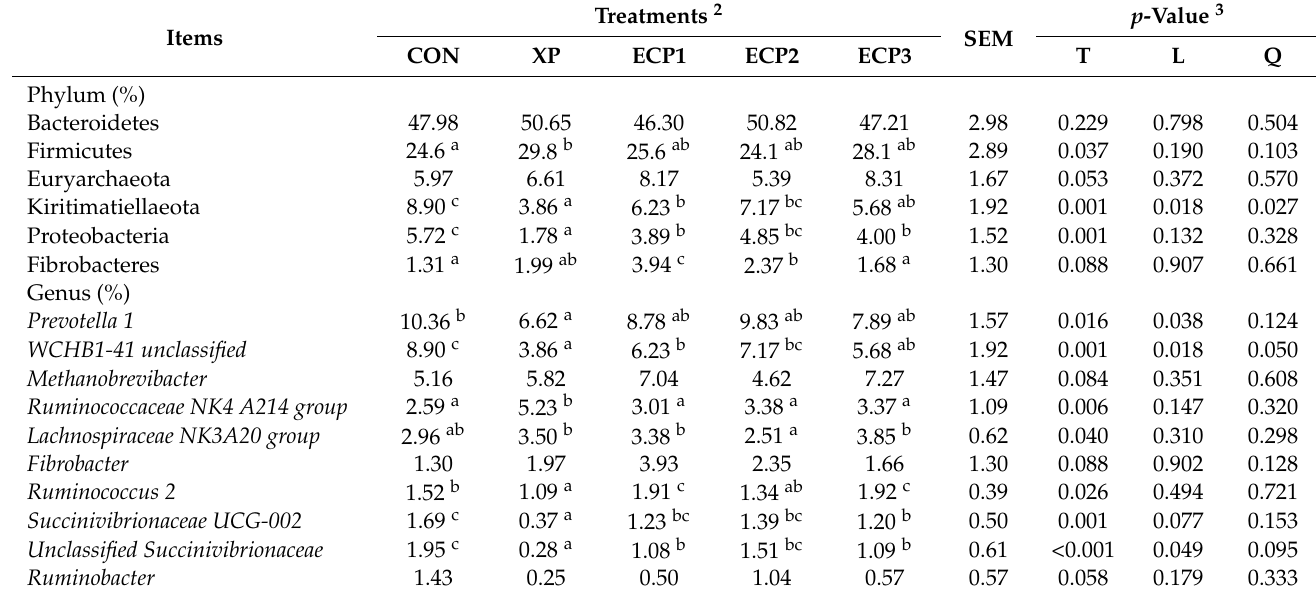
Table 6. Relative abundance of bacteria under different levels of ECP supplementation 1